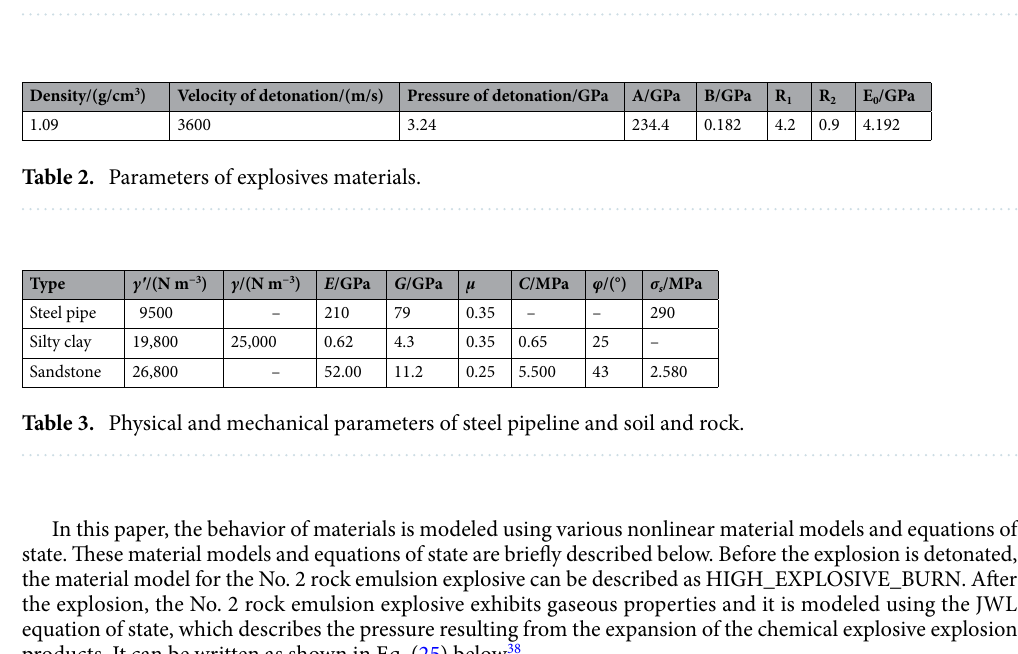
Figure 6. Schematic diagram of the computational model.